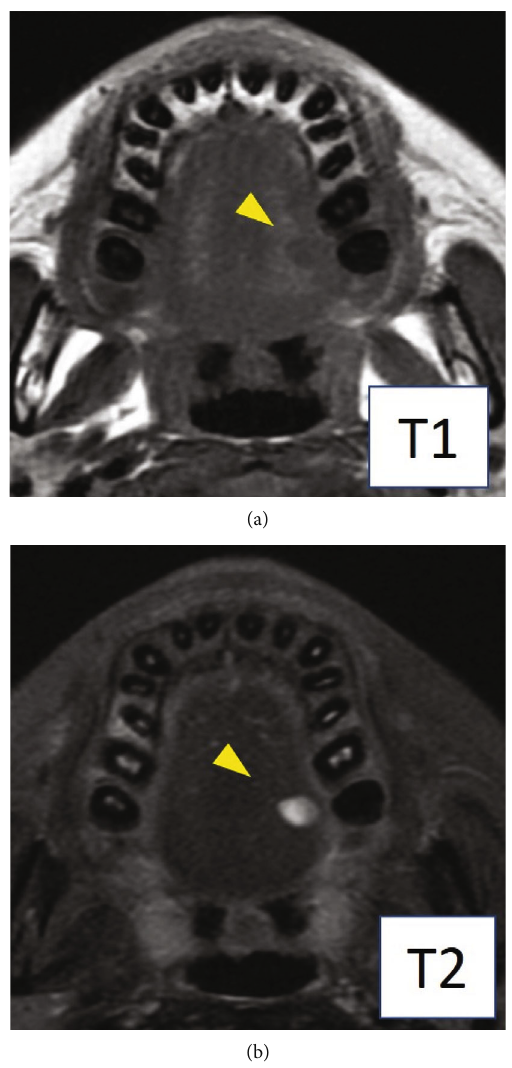
Figure 2: Magnetic resonance imaging fi ndings. (a) T1-weighted axial image showing low signal intensity within the lesion (arrowhead). (b) T2-weighted axial image showing increased signal intensity within the lesion